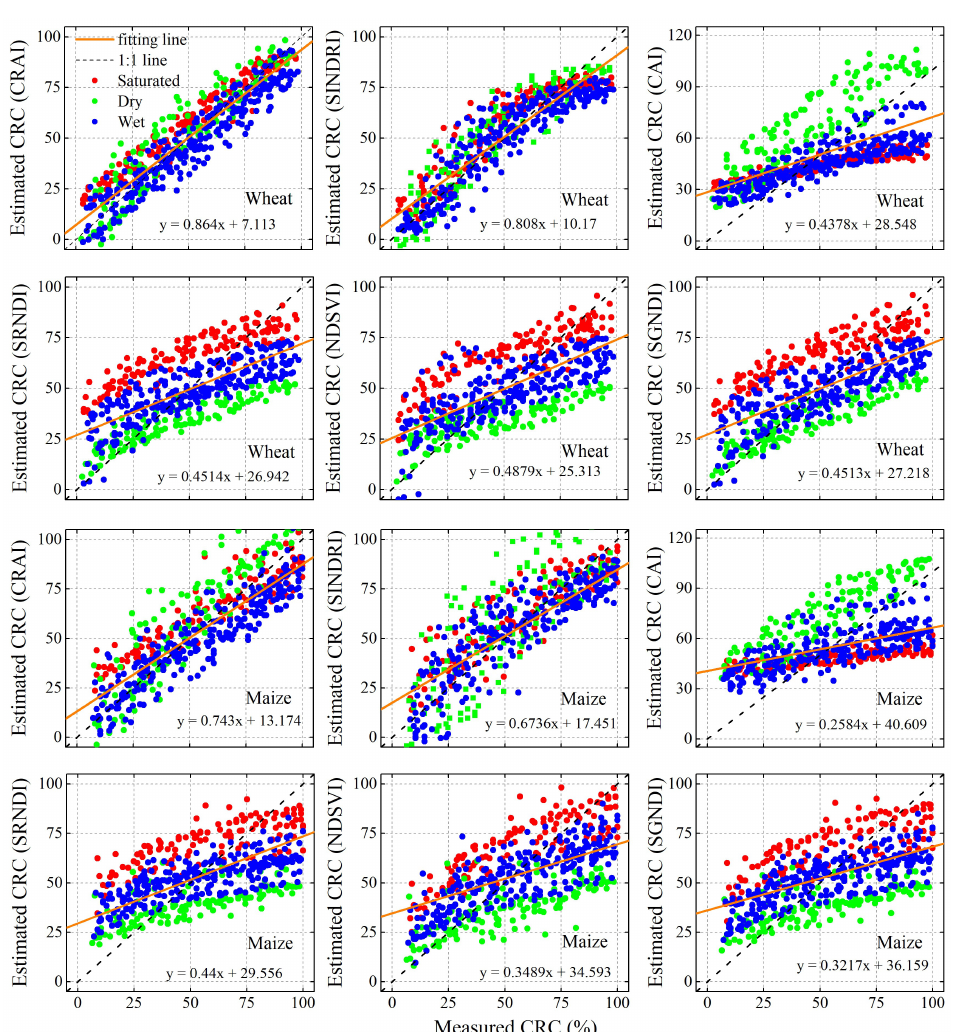
Figure 10. Correlation between estimated and measured CRC (validation dataset: n = 556 for wheat and n = 522 for maize, formula y = a × x + b represent the fit line ).